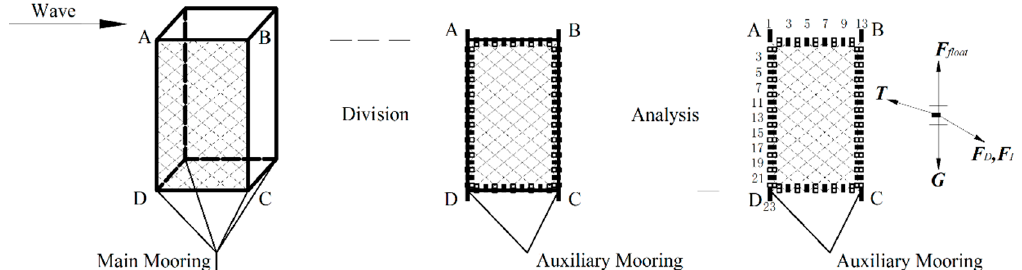
Figure 1. Unit division and force analysis of the floating frame.